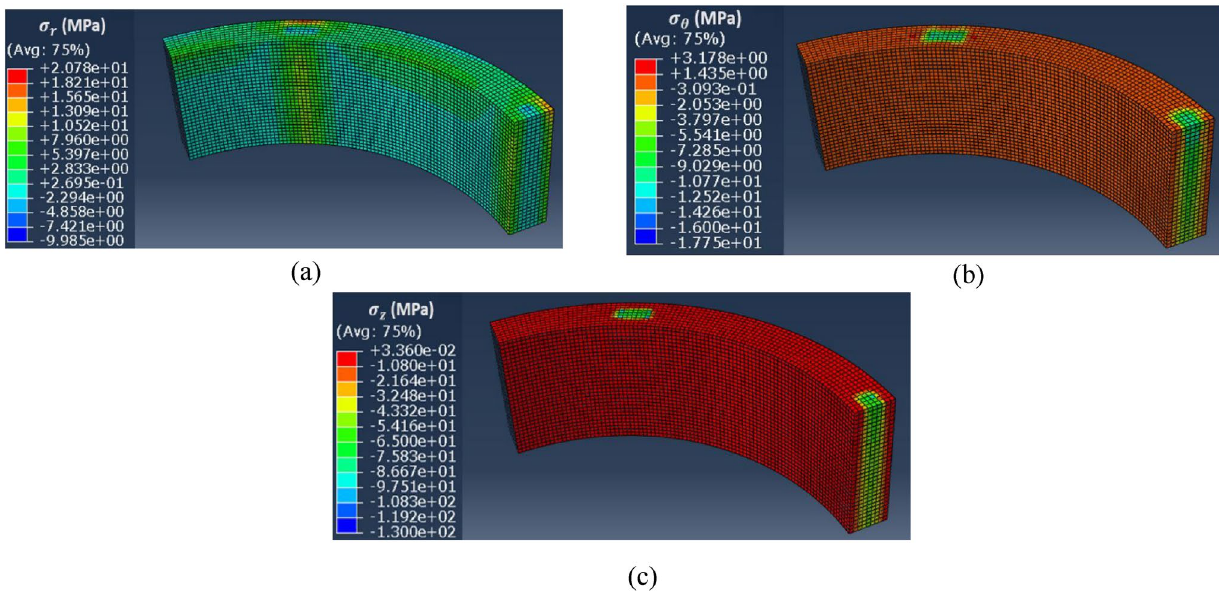
Figure 24. Mechanical stress distribution for the inhomogeneous case (4 MPa). ( a ) Radial ( u r ) , ( b ) Orthoradial ( u θ ) and ( c ) Axial ( u z